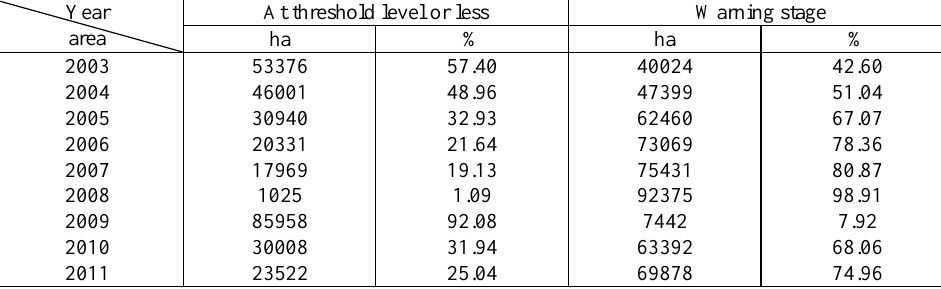
Table 2. The extent of areas under warning based on groundwater drop during